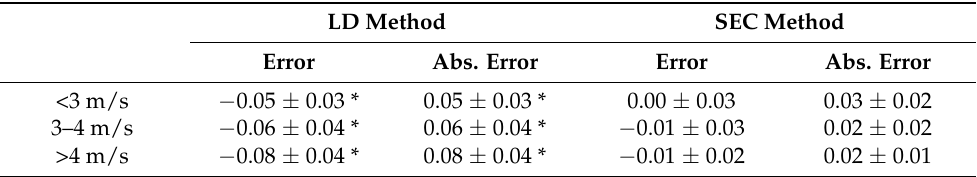
Table 5. Intraclass correlation coefficient (ICC) and confidence interval (CI) of ICC for stride length estimated by linear dedrifting (LD) method and spatial error correcting (SEC) method at different speed ranges.